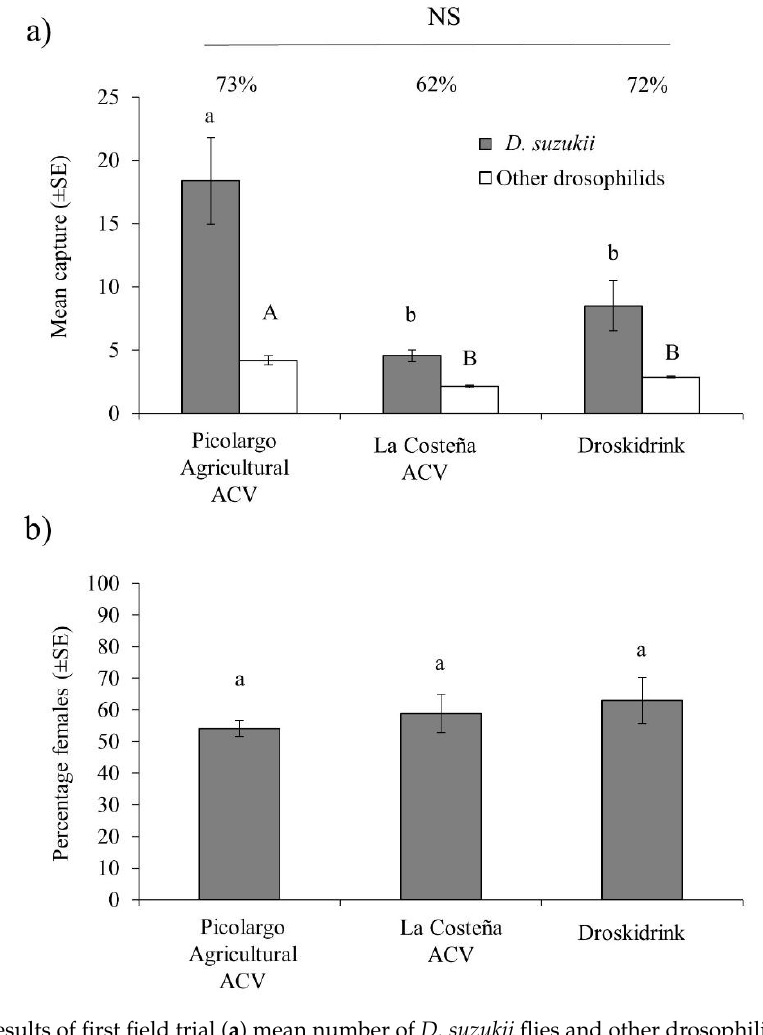
Figure 2. Results of first field trial ( a ) mean number of D. suzukii flies and other drosophilids captured per trap per week over the three-week trial and ( b ) mean percentage of females captured in traps containing agricultural-grade ACV, La Costeña ACV and Droskidrink. Columns headed by different letters differ significantly for captures of both sexes of D. suzukii (lower case letters) or other drosophilid species (upper case letters) (GLM, p < 0.05). Vertical bars indicate SE. Species specificity percentage values are shown above columns in ( a ) (GLM, NS indicates p > 0.05). Attractant specificity, measured as the ratio of D. suzukii to total flies captured per trap, varied between 62–73% among all treatments and did not differ significantly (GLM: χ 2 = 2.92, df = 2, p =